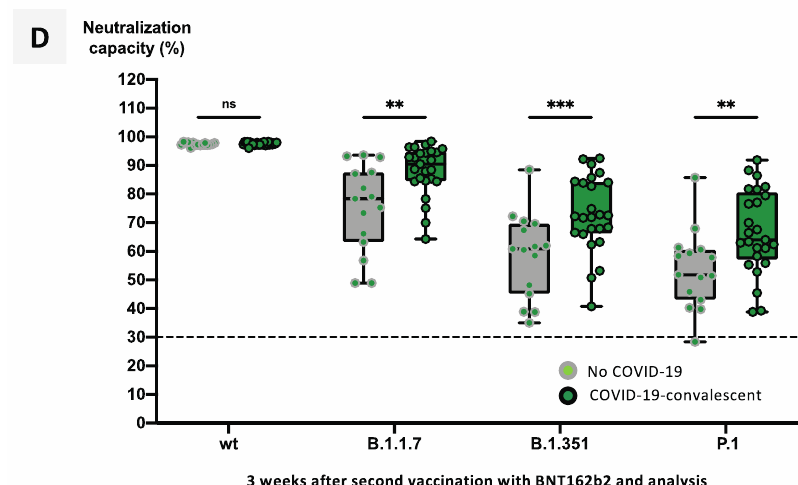
Figure 2. Impact of previous SARS-CoV-2 infection on the neutralizing capacity after vaccination with BNT162b2. Serum samples from 15 BNT162b2-vaccinated individuals without history of COVID-19 (cohort B) and 25 COVID-19-reconvalescent BNT162b2-vaccinated individuals (cohort C) were collected at different timepoints after their first vaccination, as indicated. ( A ) Line graphs show individual courses for the neutralization capacity of ACE2–RBD interaction. ( B ) Boxplots show median neutralization capacities at the time of first vaccination (0 weeks), second vaccination (3 weeks), and 3 weeks after second vaccination (6 weeks). ( C ) Boxplots show median anti-NCP IgG titers for COVID-19-naïve versus COVID-19-convalescent donors. ( D ) Boxplots show neutralization capacities against RBD variants as indicated in BNT162b2-vaccinated COVID-19-naïve versus COVID-19-convalescent individuals. Box central horizontal lines in ( B , C ) indicate medians, box borders represent IQR, and whiskers indicate minima and maxima. For statistics, Š í d á k’s test for multiple comparisons ( B , D ), and the Mann–Whitney U test ( C ) were used. Significance levels were ** p < 0.005, *** p < 0.0005, and **** p < 0.00005. Abbreviations: COVID-19: coronavirus disease 2019; ACE2: angiotensin-converting enzyme 2; RBD: receptor-binding domain; IQR: interquartile range; n.s.: not